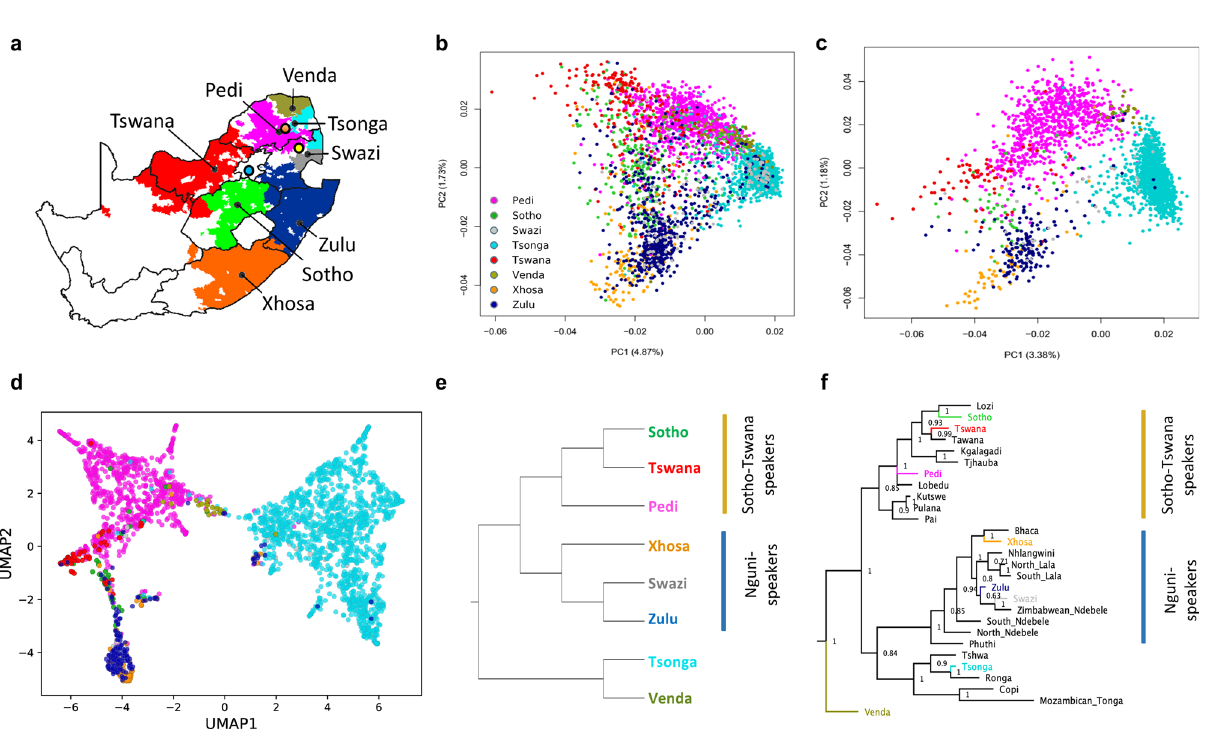
Fig. 1 Population structure and genetic af fi nities of South-Eastern Bantu-speaking (SEB) groups from South Africa correspond to both linguistic phylogeny and geographic distribution. a Map showing the language majority areas (LMAs) of each SEB group. The centroid of each of the regions is indicated using a black dot. The three sampling sites are shown in coloured circles; Soweto in blue, Dikgale in orange and Agincourt in yellow. The original map was obtained from: https://en.wikipedia.org/wiki/Languages_of_South_Africa#/media/File:South_Africa_2011_dominant_language_map.svg. The user acknowledges Stats SA as the source of the basic data wherever they process, apply, utilise, publish or distribute the data, and also that they specify that the relevant application and analysis (where applicable) result from their own processing of the data. The language centroid points were calculated for this study (see methods for details). b Principal Component (PC) plot for the unrelated SEB samples (Pedi N = 1065, Sotho N = 366, Swazi N = 126, Tsonga N = 1644, Tswana N = 242, Venda N = 73, Xhosa N = 177 and Zulu N = 626) shows an overall correspondence between the distribution of SEB groups on the geographic map and the PCA. The colours showing the LMA for each SEB group on the geographic map corresponds to the colours used for the SEB group in the PCA. c PC plot based on ethno-linguistically concordant samples (self-reported ancestry of the participant is the same as at least 5 of the parents and grandparents) (Pedi N = 851, Sotho N = 46, Swazi N = 30, Tsonga N = 1438, Tswana N = 73, Venda N = 24, Xhosa N = 63 and Zulu N = 177) shows much clearer separation between the three major linguistic divisions (Sotho-Tswana, Nguni, and Tsonga speakers). d A composite representation of the fi rst 10 PCs (generated using PCA-UMAP) also shows separation of the SEB groups corresponding to the three major linguistic divisions. e UPGMA tree based on pairwise F ST distance between SEB groups. Sample sizes are same as of panels c . f , Linguistic phylogeny based on lexical data (majority-rule consensus tree) with posterior probability values. The SEB groups from the current study are indicated using the same colours as used in the PCA plots. The topology of the trees in e and f shows an overall